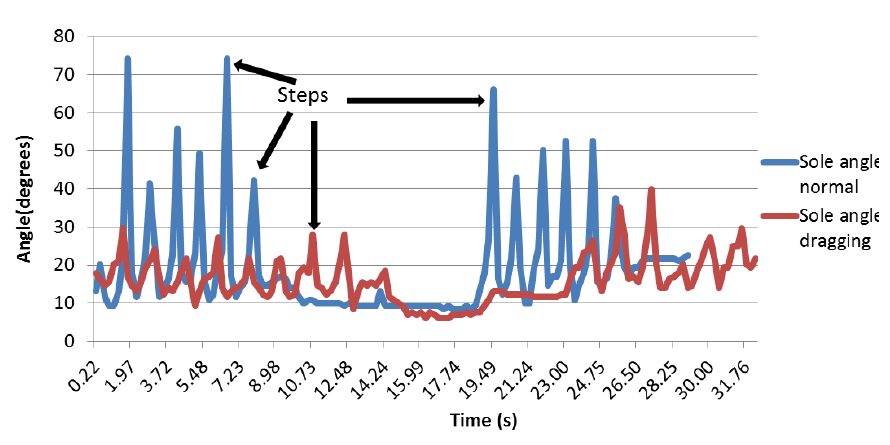
Figure 23. Sole angle curves.